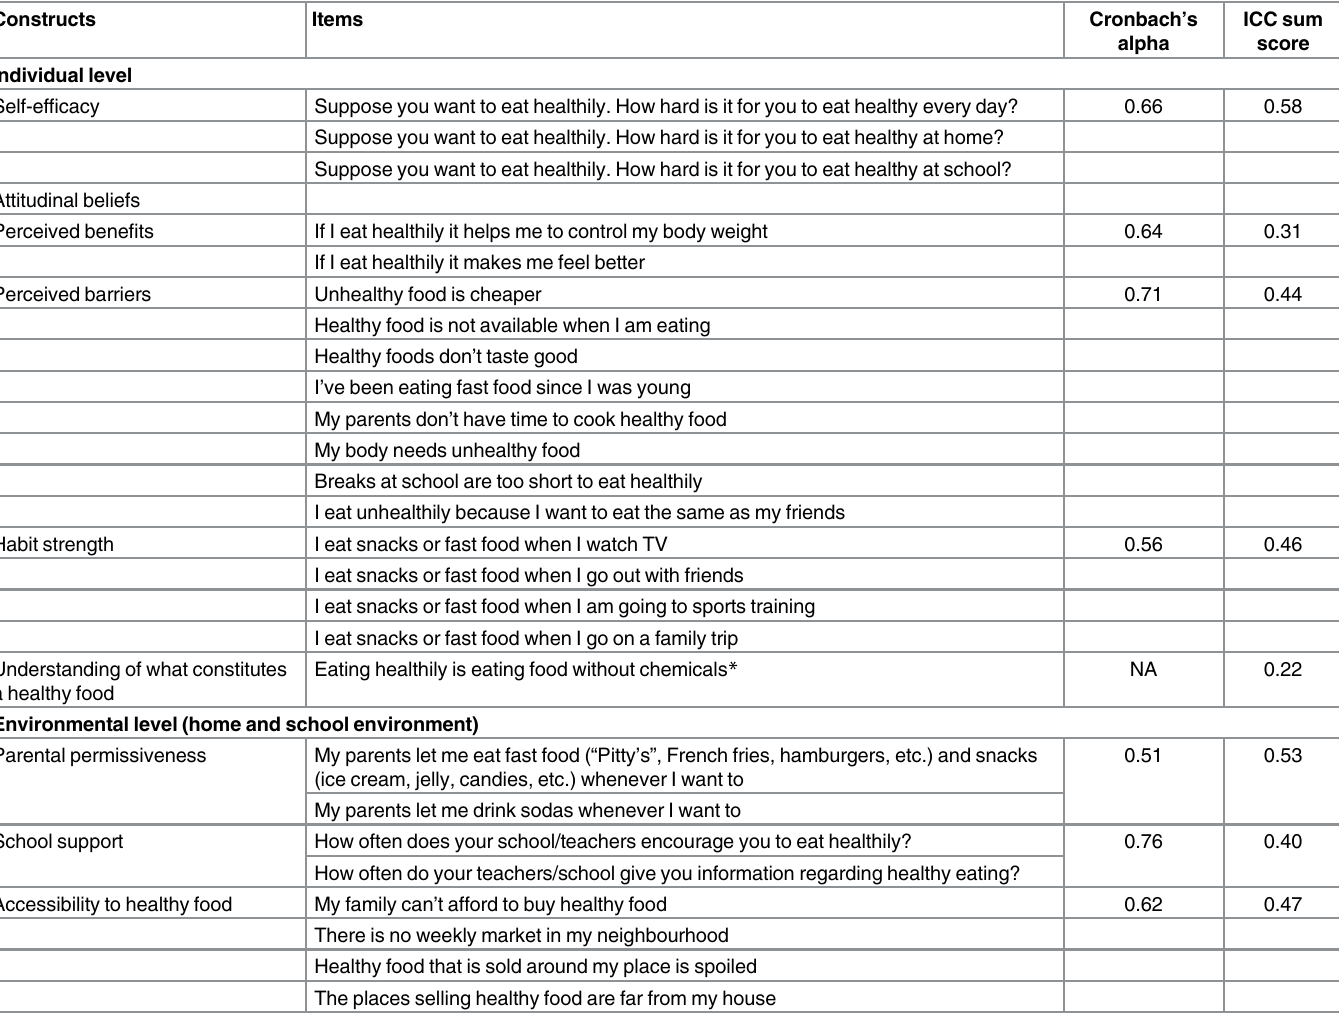
Table 3. Cronbach ’ s alpha and Intra-class Correlation Coefficient for retained constructs in the model at individual and environmental